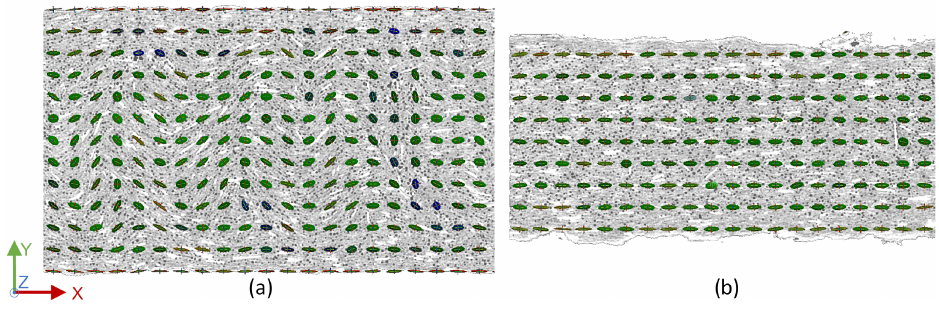
Figure 10. Top view of the fiber orientation tensors of a single-strand specimen at a substrate temperature of 130 °C at ( a ) the center of a strand and ( b ) at the interface between two